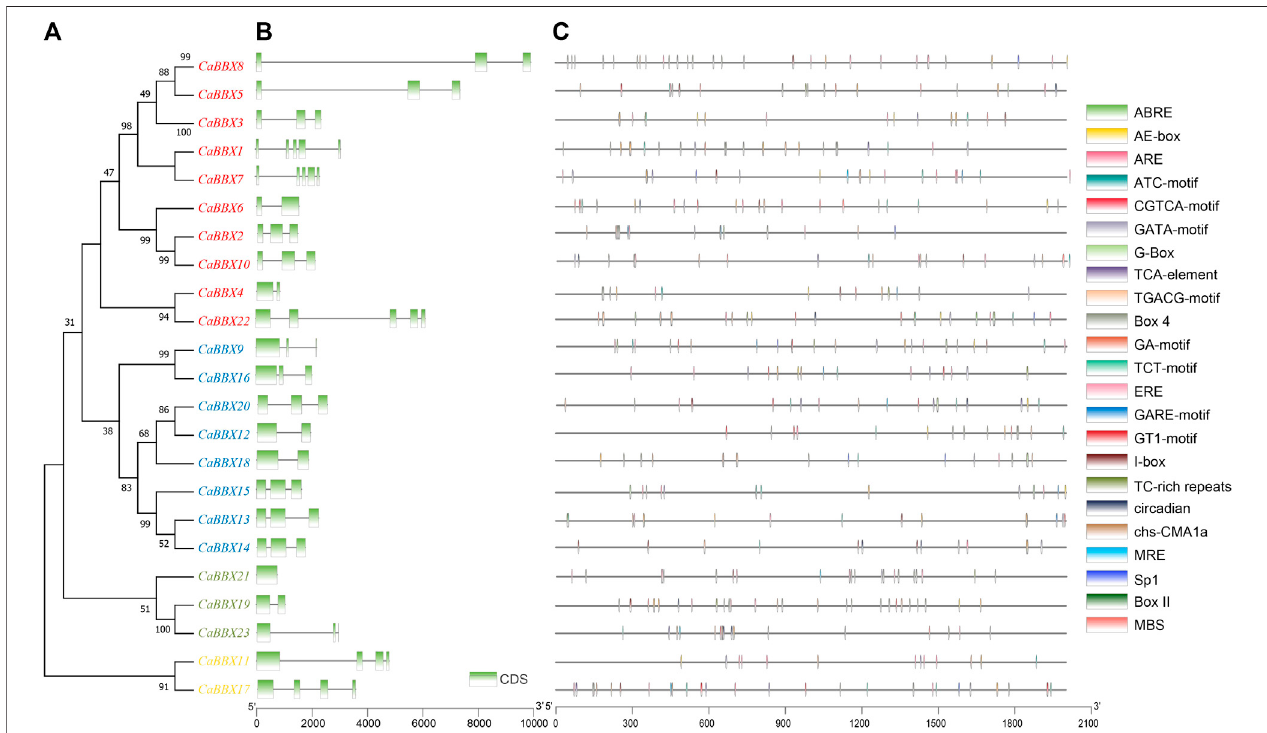
FIGURE2| Phylogeneticrelationships, genestructure analysis,and predicted cis -elements of CaBBXs . (A) Phylogenetic treeforthe23 CaBBXs .Red geneswere classi fi ed in Group I, blue members belonged to Group II, green genes to Group III, and yellow members to Group IV. (B) Green boxes represent the coding sequence (CDS) regions while intron regions are indicated by black lines. Exon lengths can be inferred from the scale at the bottom. (C) Promoter sequences ( − 2,000 bp) of CaBBX s were analyzed using PlantCARE. Different shapes and colors represent different elements. Annotated cis -elements are listed in